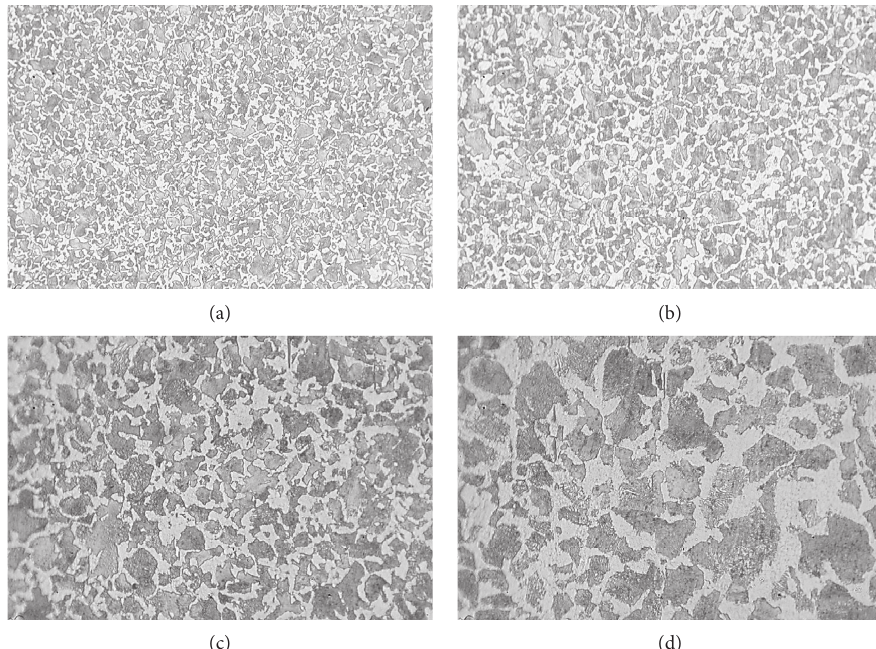
Figure 18: The microstructure of the deposited steel S 45 sample after normalization from induction heating to 880 ° S in air (a, c) and in a